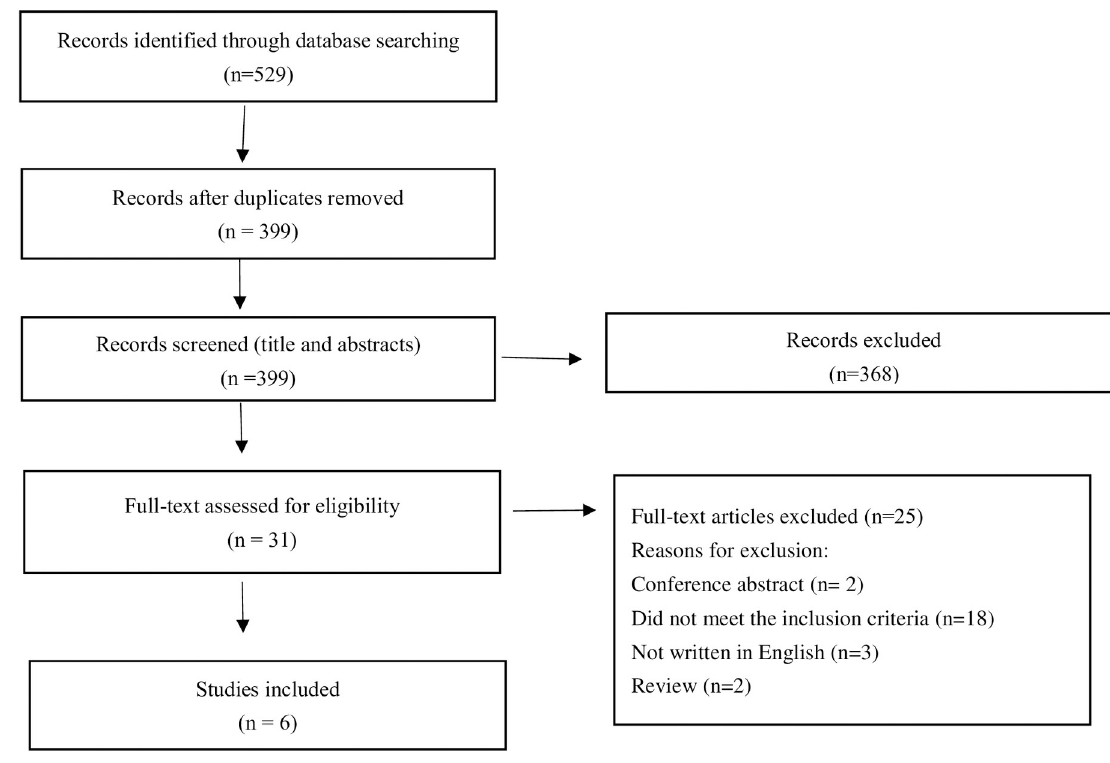
Fig 1. Flowchart selection